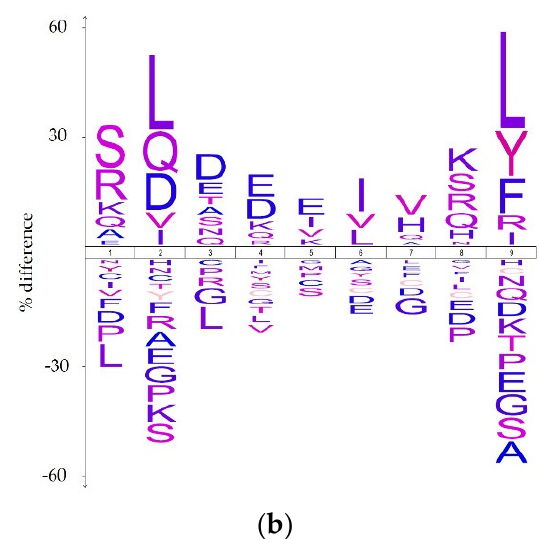
Figure 2. Length and sequence conservation of LC-MS/MS identified peptides from mock-infected PAMs searched against the Sus scrofa proteome. ( a ) Peptide sequence length (amino acids) of MHC- I-bound porcine peptides. Percentages of total isolated peptides are displayed above the bars. ( b ) Sequence logo of 9-mer peptides, depicting percent differences of amino acid frequencies from the Sus scrofa proteome as a reference.